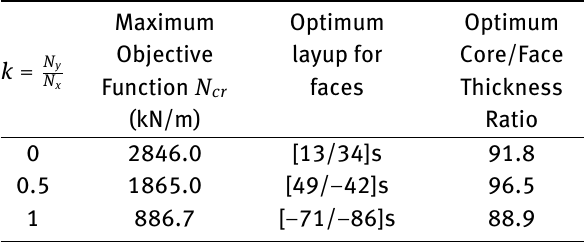
Table 5: Optimisation of a fully clamped sandwich cylindrical panel with isotropic